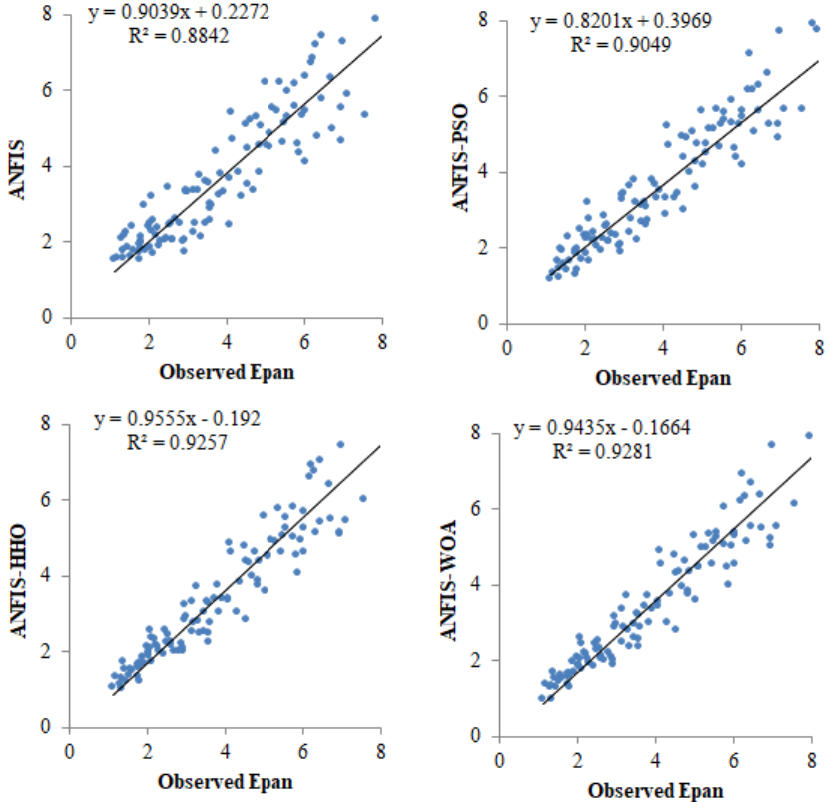
Figure 5. Scatterplots of the observed and predicted Epan using the hybridized ANFIS models in the testing phase using the best input combination — Yueyang Station.